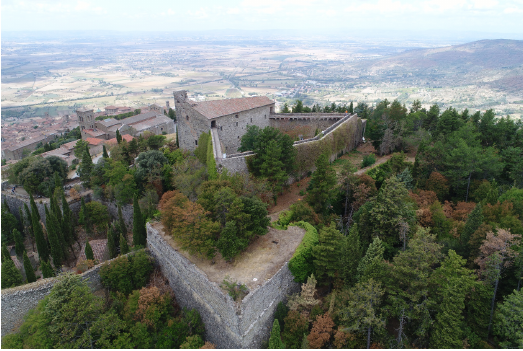
Figure 1. Girifalco fortress, Cortona, Italy.